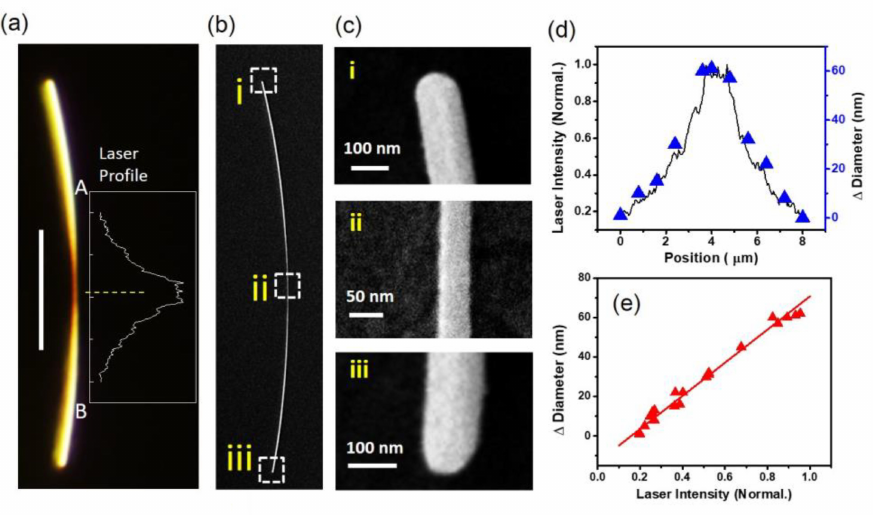
Figure 2. Relationship between NW morphological changes and laser intensity. ( a ) Dark field image of a NW after 25 s laser illumination. The laser power is 200 mW. The white dashed circle indicates the focused laser spot. The scale bar is 5 µ m. ( b ) SEM image of the NW in ( a ). ( c ) Zoomed in SEM images of the area ( i – iii ). ( d ) Laser intensity and NW diameter changes from position A to B along the NW as shown in ( c ). ( e ) Relationship between NW diameter changes and laser intensity.